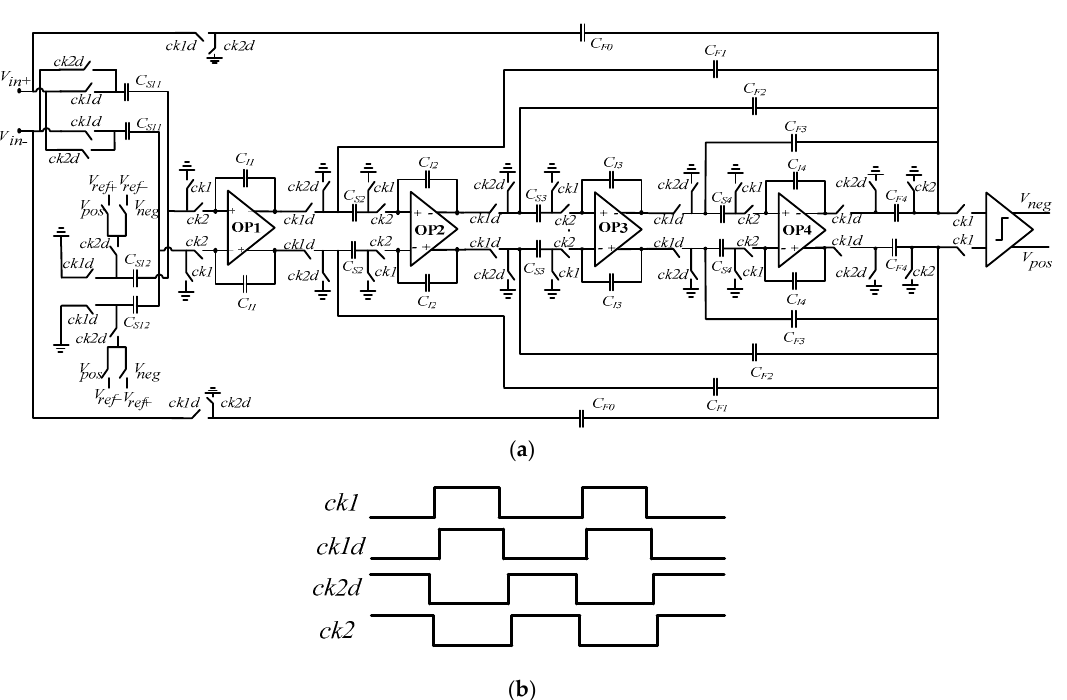
Figure 5. ( a ) High-order ΣΔ modulator circuit; ( b ) the timing diagram of ΣΔ modulator circuit.